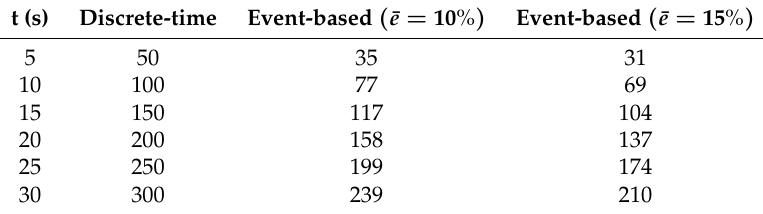
Table 1. RF channel utilization in the wall following algorithm. Number of accumulated transmissions. t